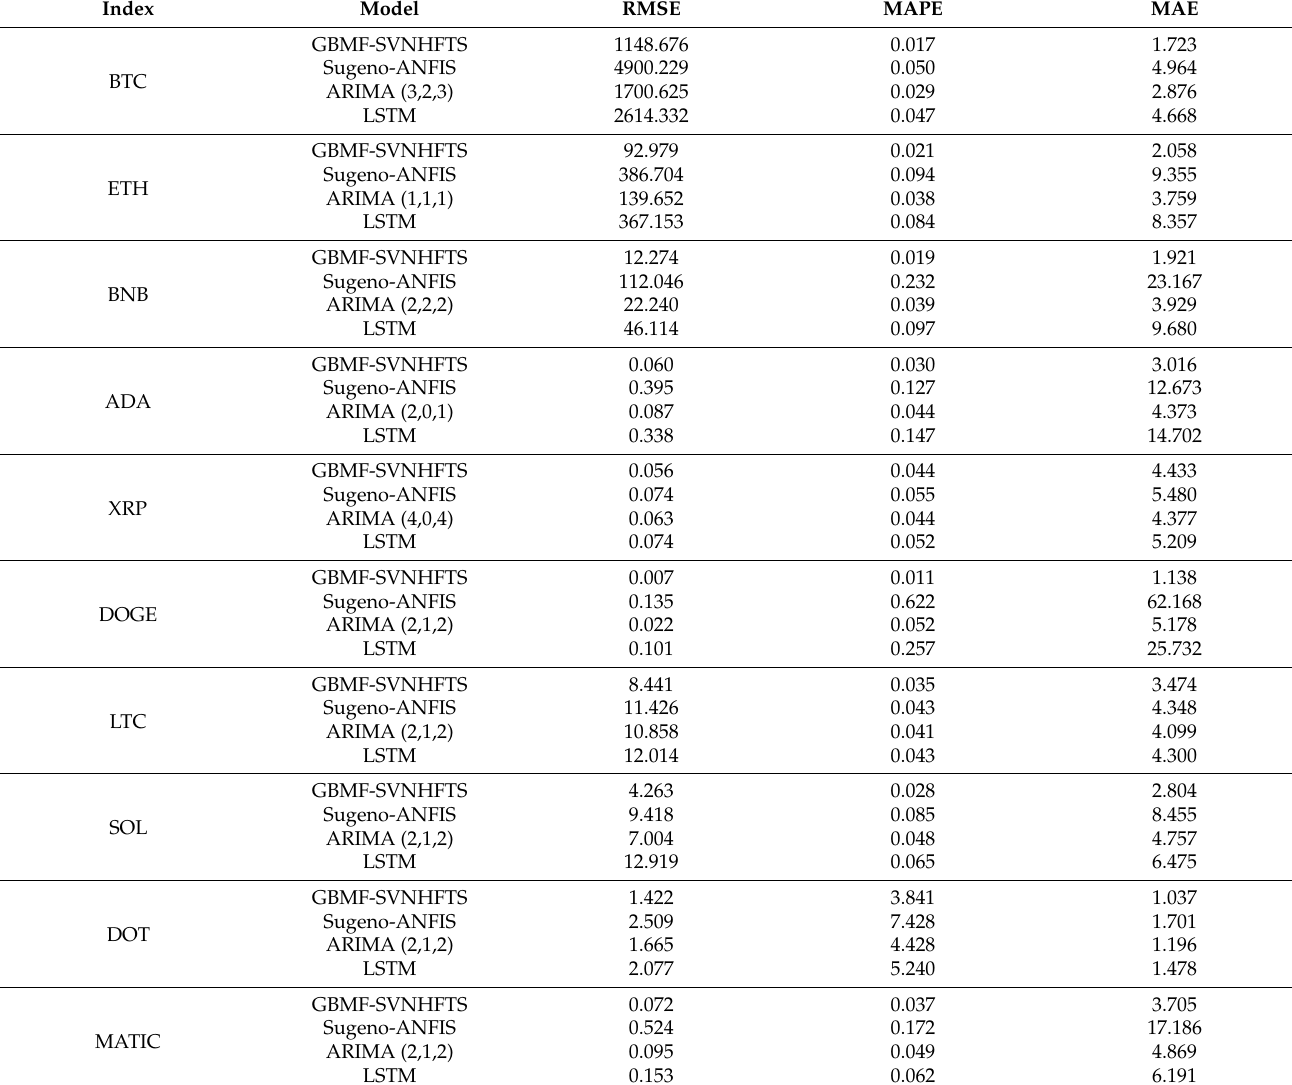
Table 4. A comparison of all three loss functions between the proposed GBMF-SVNHFTS method and existing methods. (Out-of-sample